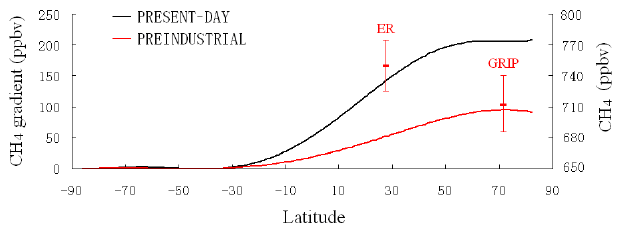
Fig. 4. CH 4 latitudinal gradients for the present-day and the prein- dustrial periods simulated with the LMDz-INCA climate–chemistry coupled model (left vertical axis), with comparison to the ER (this study) and the GRIP (Chappellaz et al., 1997) records (right vertical